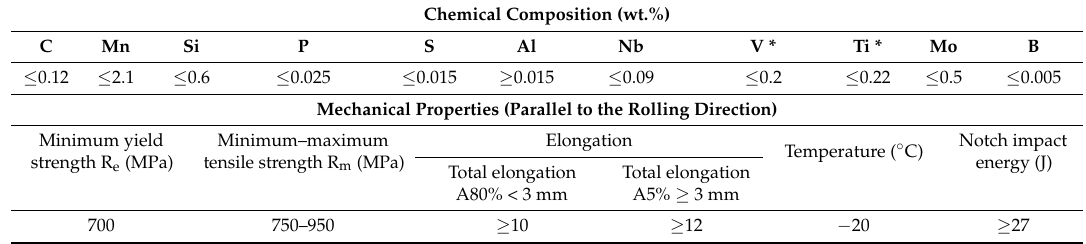
Table 1. Chemical composition and typical properties of S700MC steel according to the EN10149-2 standard. Chemical Composition